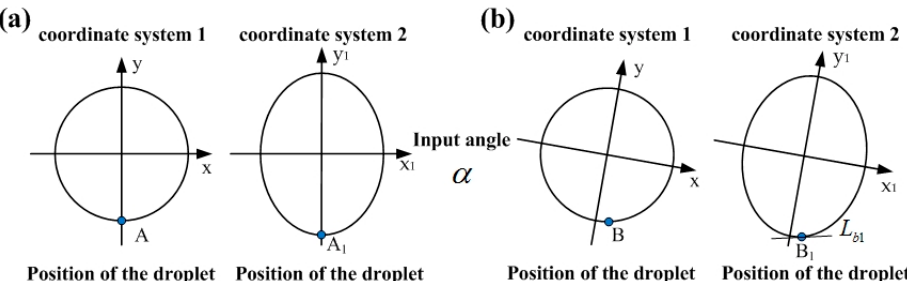
Figure 3. The position of the droplet in the annular groove. ( a ) Initial position, ( b ) position after input angle.